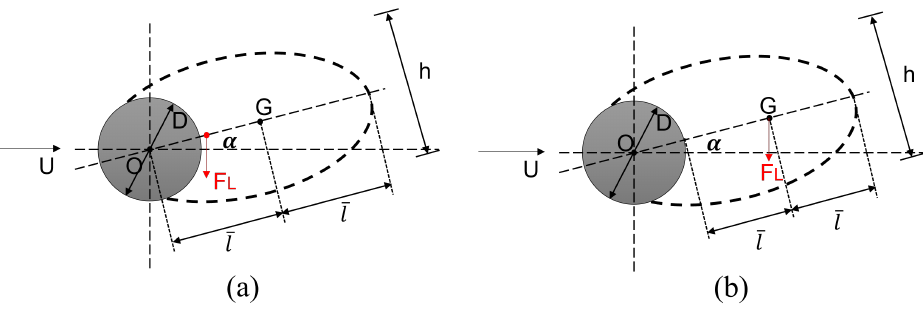
Figure 4. A schematic of the wake oscillator model developed by ( a ) Birkhoff [34] and ( b ) Funakawa